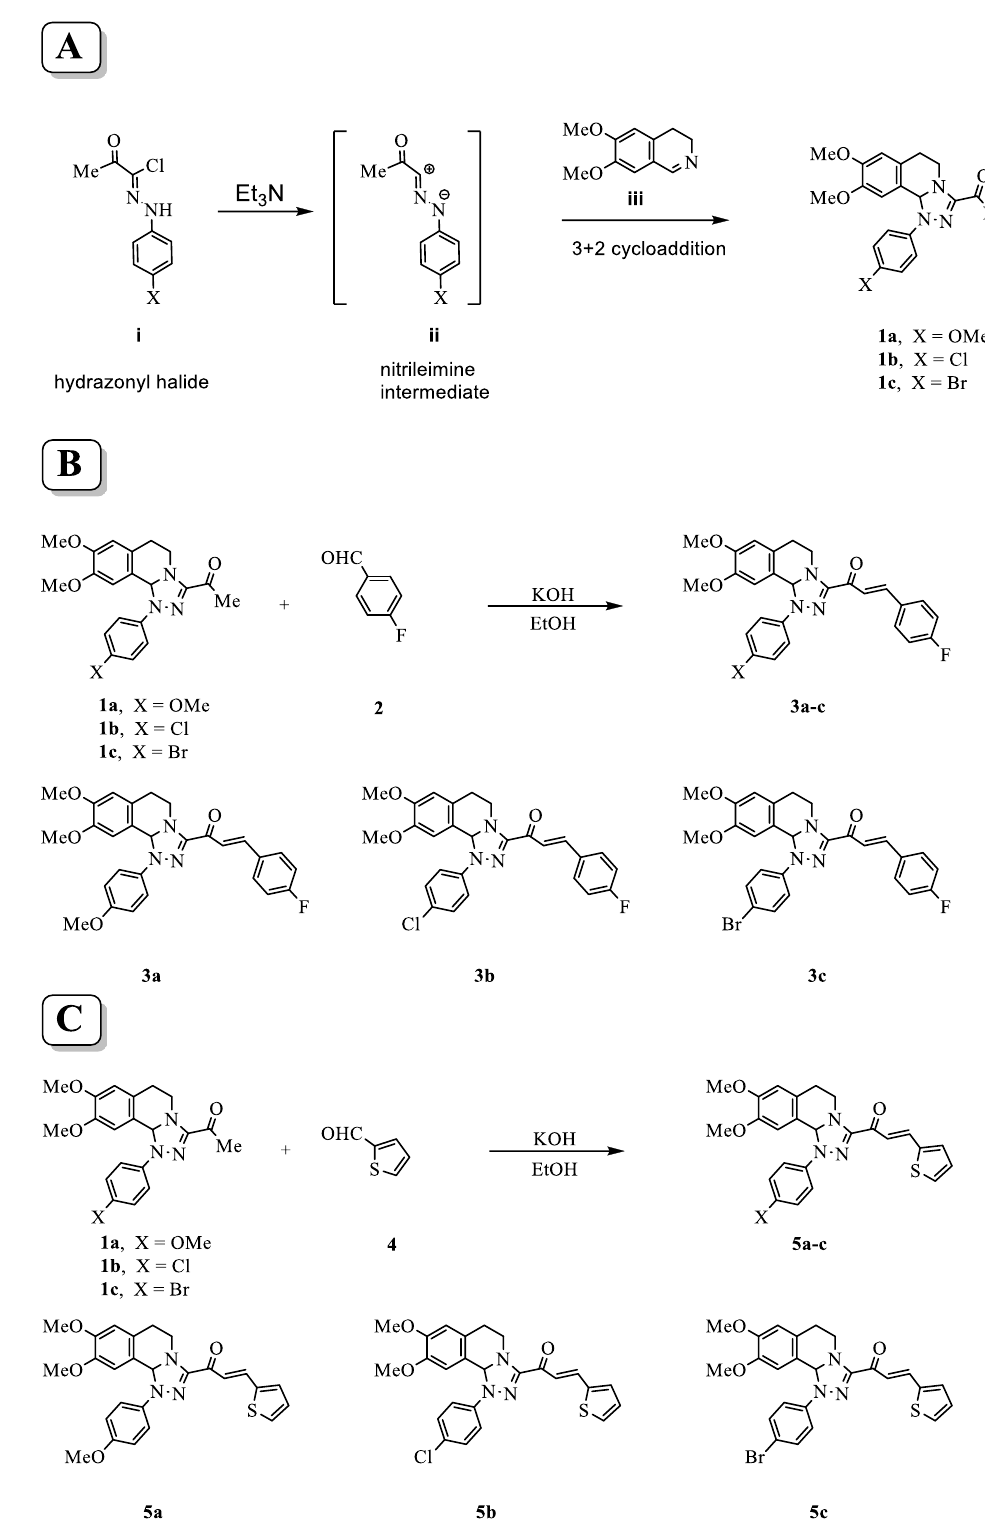
Figure 1. Scheme for the synthesis of tetrahydro-[1,2,4]triazolo[3,4- a ]isoquinolin-3-yl)-3-arylprop-2- en-1-one chalcone derivatives. ( A ) Procedures of the reaction to form the parent compounds ( 1a – c ) through the reactions of nitrilimine ii with 3,4-dihydro-6,7-dimethoxyisoquinoline iii . ( B ) Formation of the chalcone derivatives ( 3a – c ) by Claisen – Schmidt condensation of compounds ( 1a – c ) with 4-fuorobenzaldehyde 2 . ( C ) Formation of the ( 5a – c ) by Claisen – Schmidt condensation of compound ( 1a – c ) with thiophene-2-carbaldehyde 4 .